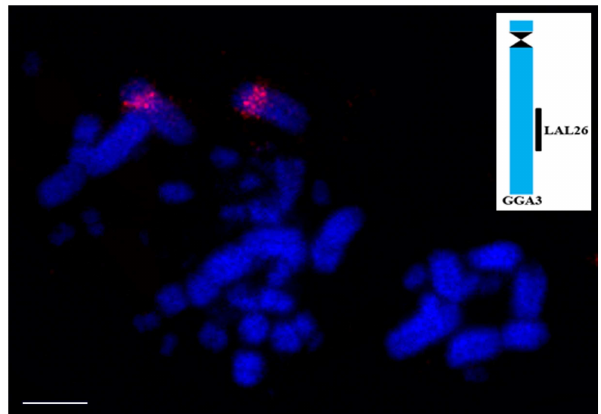
Figure 4. Result of comparative chromosome painting using probe, corresponding to LAL26, labeled in red (CY3), on metaphases of Rhea americana . These probes hybridize on the same position as in Gallus gallus , confirming that the organization of Ratites and Gallus are similar and might correspond to the ancestral organization found in PAK. Scale bar: 5 µ